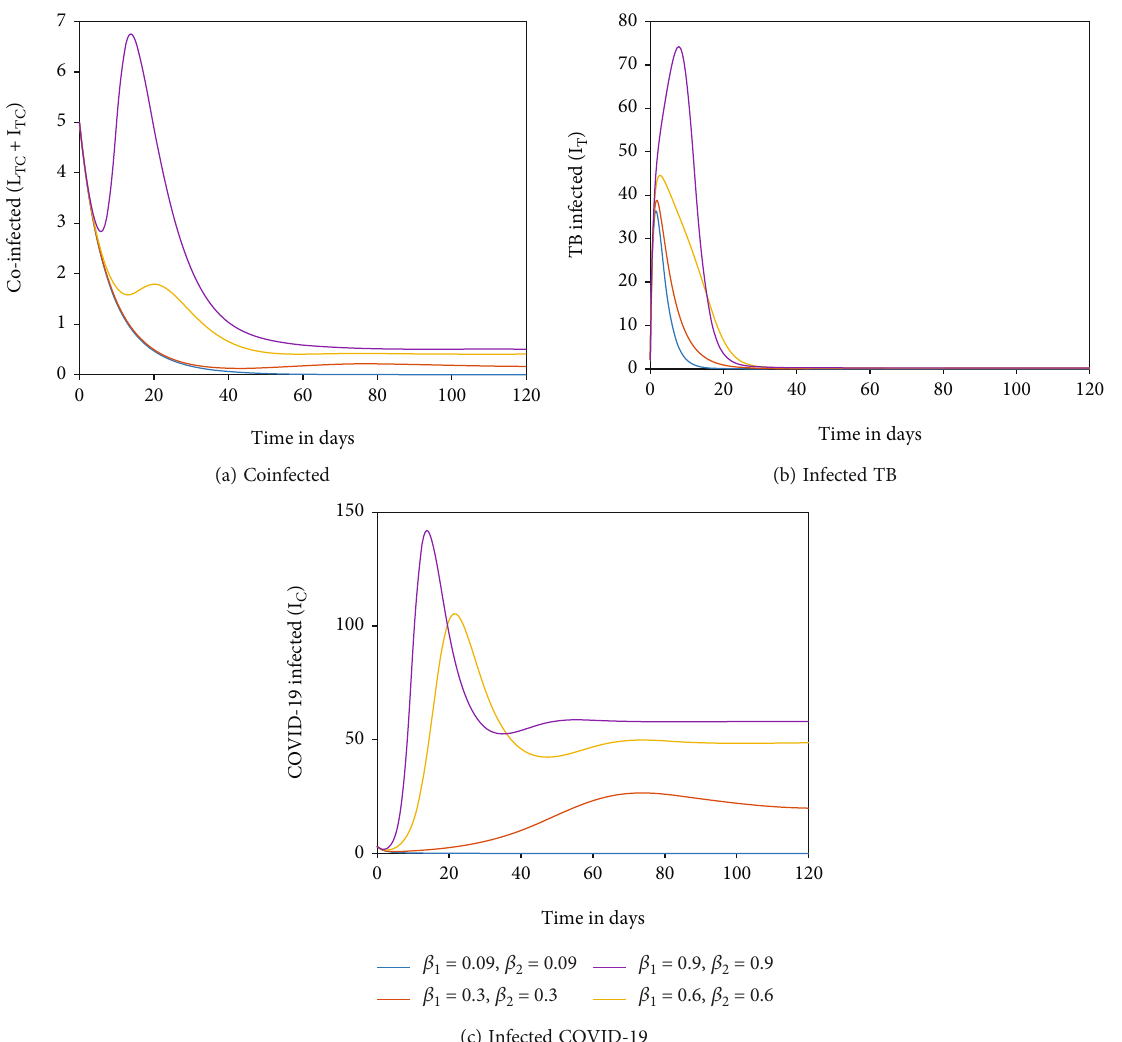
I C ) infected, and coinfected